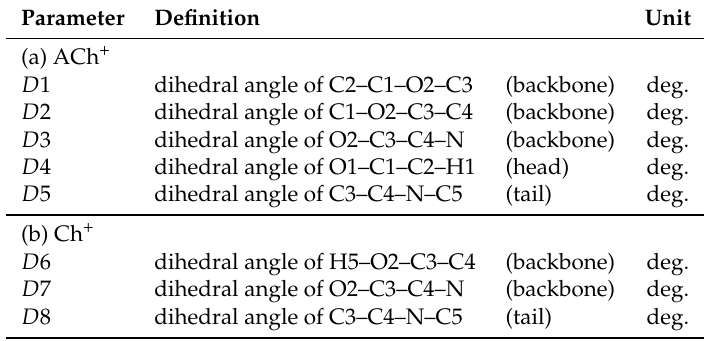
Table 1. The geometrical parameters of interest from Figure 1 and the corresponding notations used throughout the